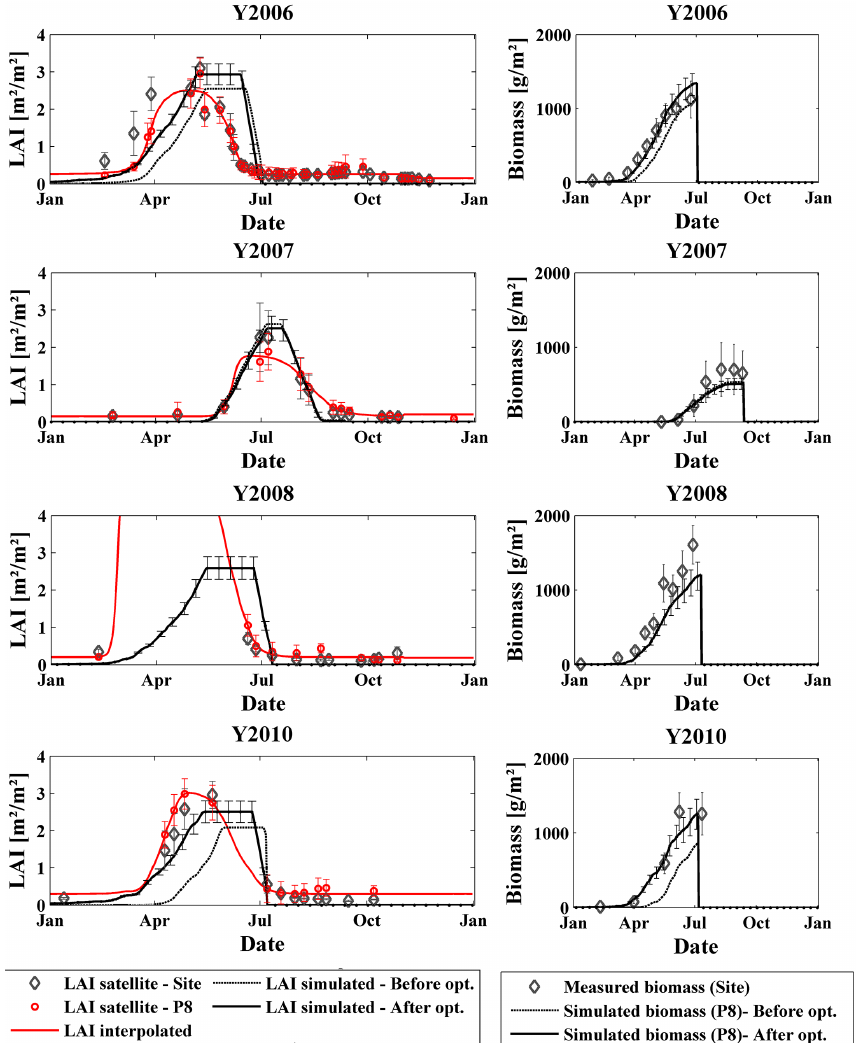
Figure 7. LAI and biomass simulated for 4 years in the crop within the catchment that exhibits a cropping pattern comparable to the experimental crop field (except in 2009) where the ground measurements are carried out. Rows stand, respectively, for winter wheat 2006, sunflower 2007, winter wheat 2008, and winter wheat 2010. LAI in the first column: the red curve is the interpolated LAI profile from the F2-derived values (red circles) with the spatial variability represented by the bars. The black diamonds represent the F2–LAI values for the experimental crop field located outside the catchment. Black solid and dotted lines are the average LAI after and before seeding date modification, respectively; bars represent the standard deviation of simulated LAI within the crop field. Biomass in the second column is represented by black diamonds for the measurements, with the measurement variability associated with the spatial variability and accuracy of the measurement method. Black solid and dotted lines are the average biomass after and before seeding date modification, respectively; bars represent the standard deviation of simulated LAI within the crop